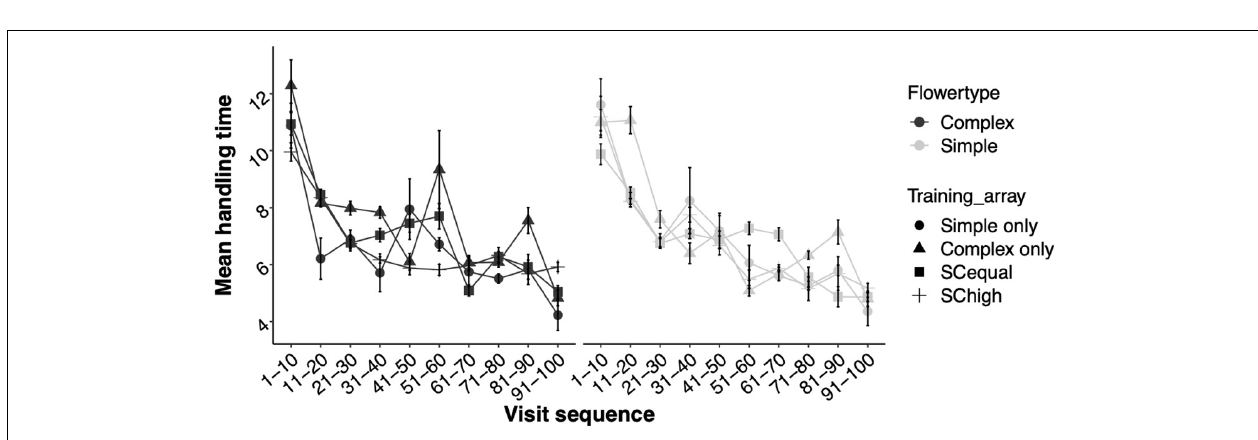
FIGURE 6 | The effects of experience during the test phase on the mean ± SE percentages of successful (fed) visits to complex flowers. As in Figure 3 , experience (visit number) was analyzed as a continuous variable in the statistical models but is plotted here in groups of 10 visits for visual clarity.